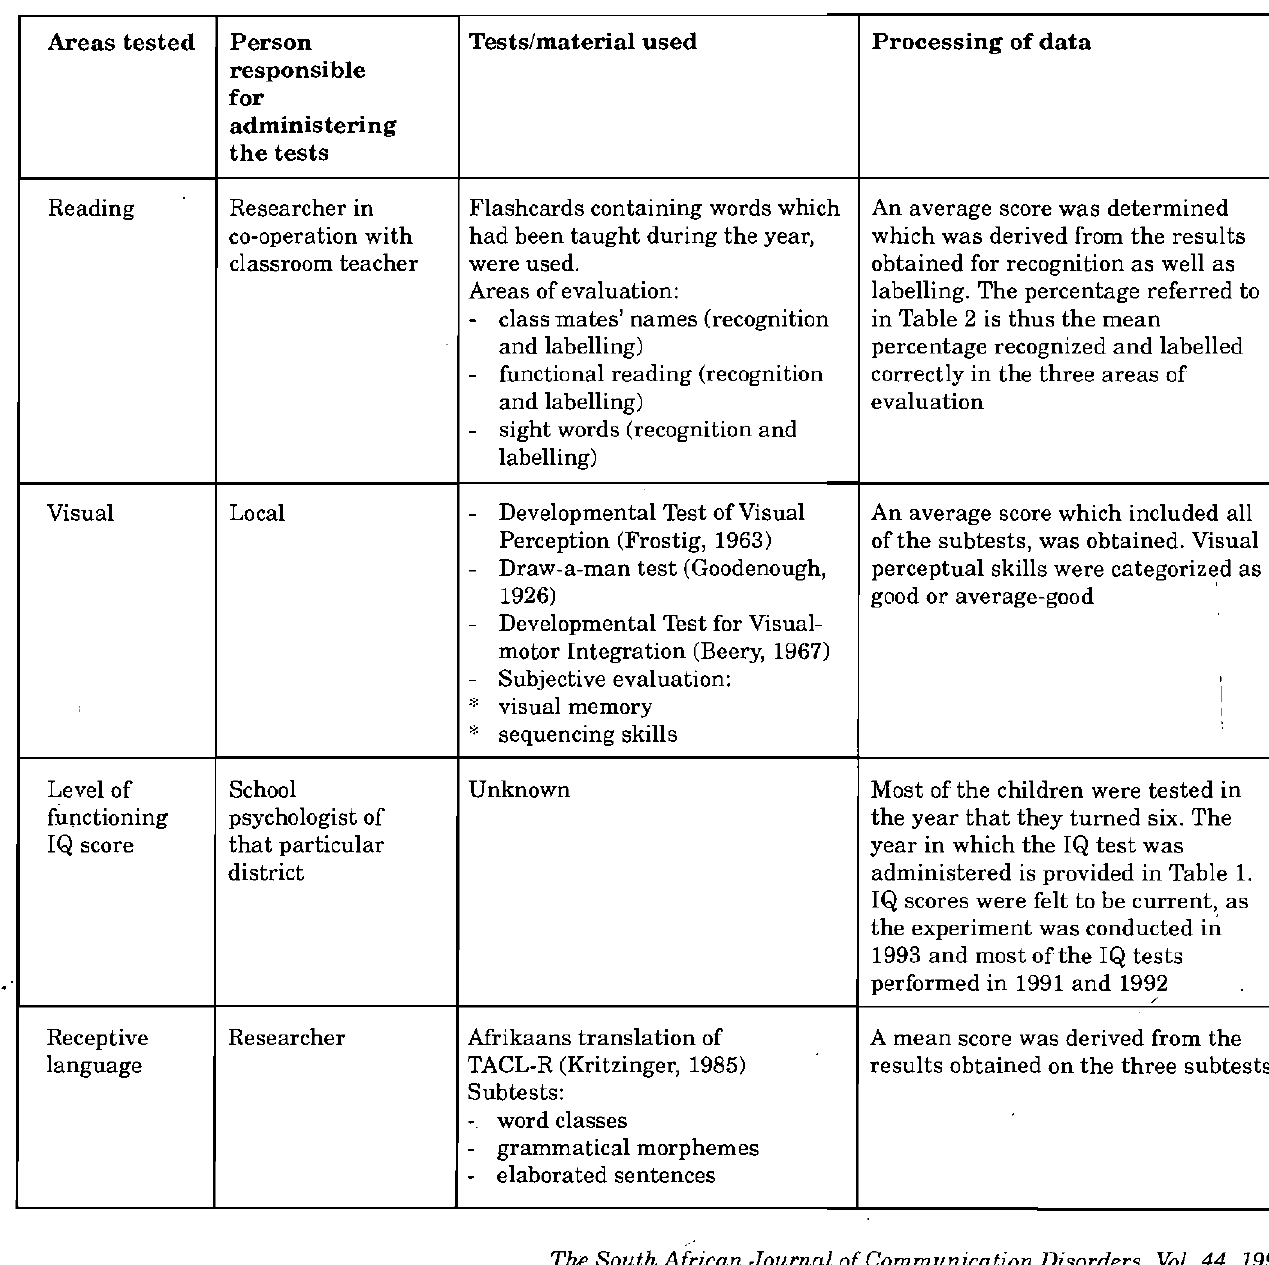
TABLE 3. Tests and material used during the pre-evaluation phase Areas